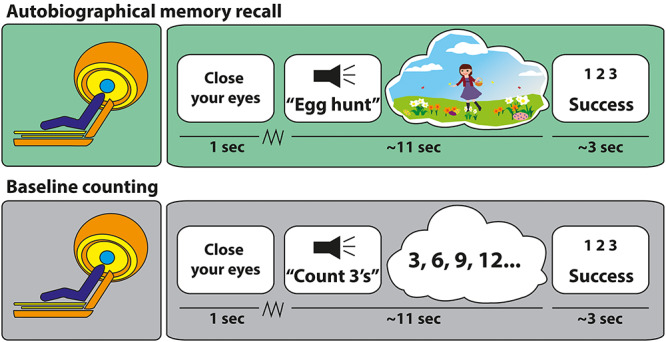
Example trials. Participants saw a cue instructing them to close their eyes, and they then waited for an auditory cue which followed a jittered duration (jagged line). Upper panel: they heard a two-word cue relating to a specific AM—this example concerned an Easter egg hunt. They then had 10 s to recall the AM in as vivid and detailed a manner as possible. At the end of each trial, participants heard a beep alerting them to open their eyes and rate the success of the retrieval (1 = engaged fully for the entire trial; 2 = partly engaged during the trial; 3 = did not engage at all during the trial). Lower panel: the counting baseline trials had the same timing, but instead of recollecting an AM, participants had to mentally count in steps of either 3’s, 7’s, or 9’s.